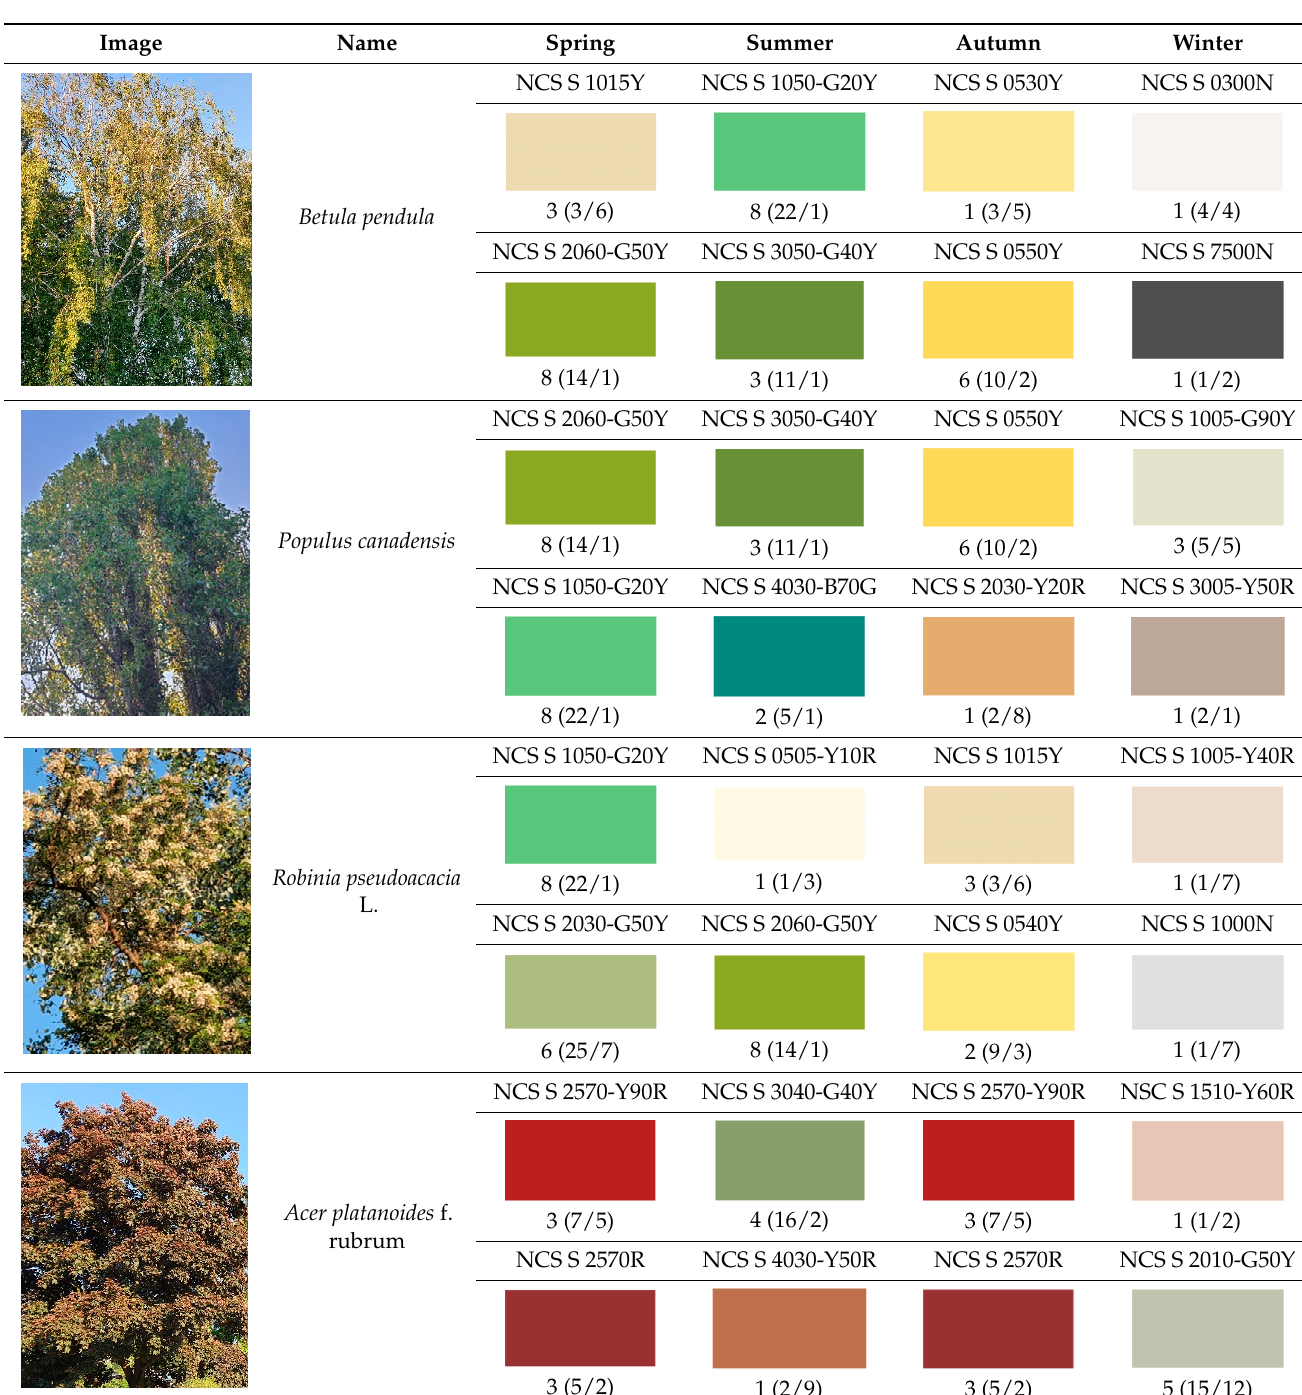
Table A1. Eighty-eight color samples taken from trees identified in the research area. The numbers below the color sample provide the information how many times a given color appears in the table (how many times it appears in all natural samples/how many times it appears in the analyzed architectural objects). Image.